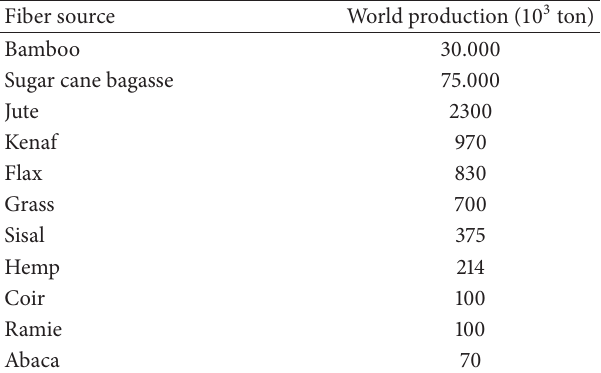
Table 1: Natural fibers in the world and their world production